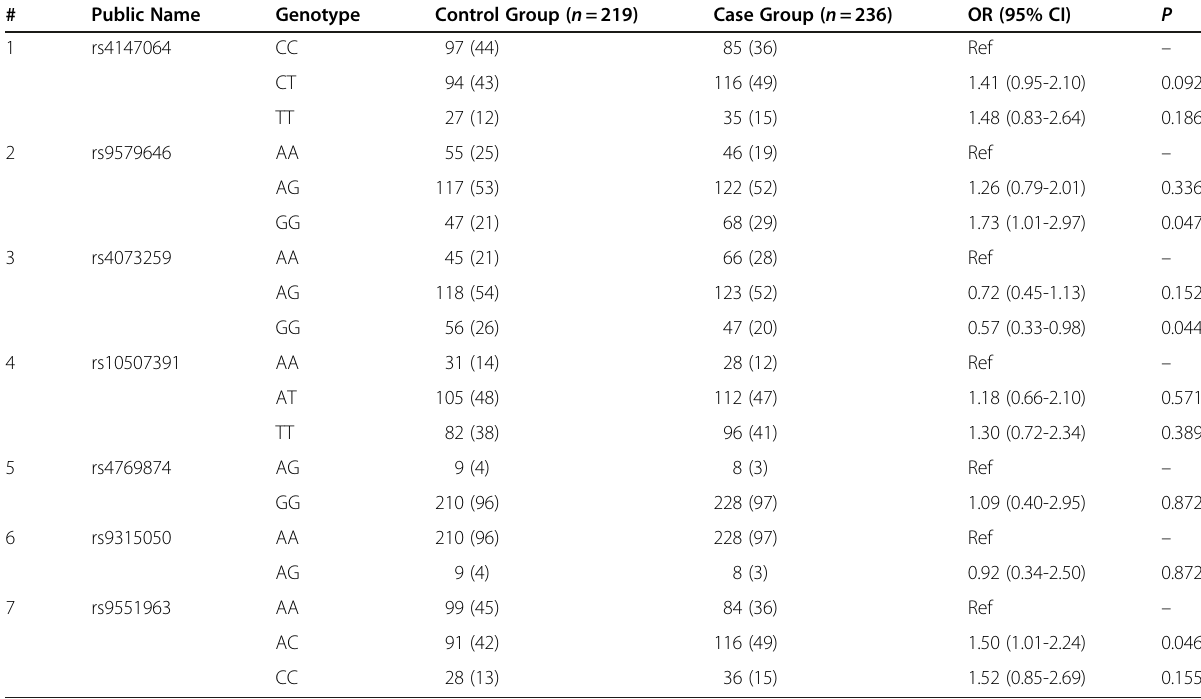
Table 3 Genotype distribution in the stroke and control